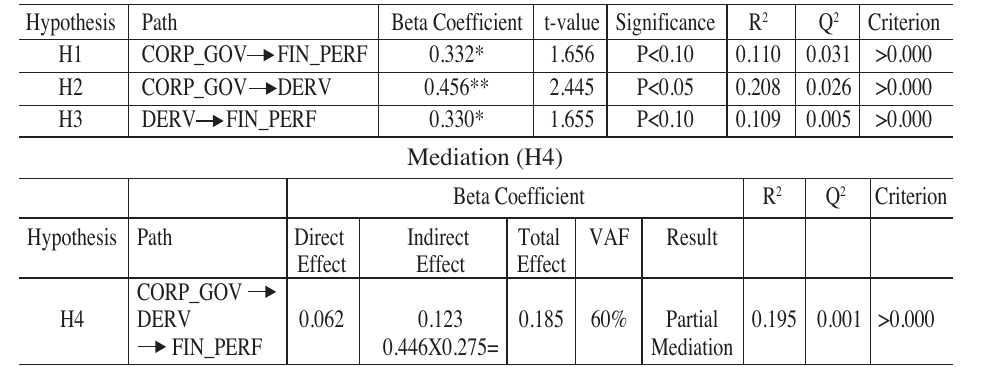
Table 15: Conditions of Mediation (H1 to H3) -2013